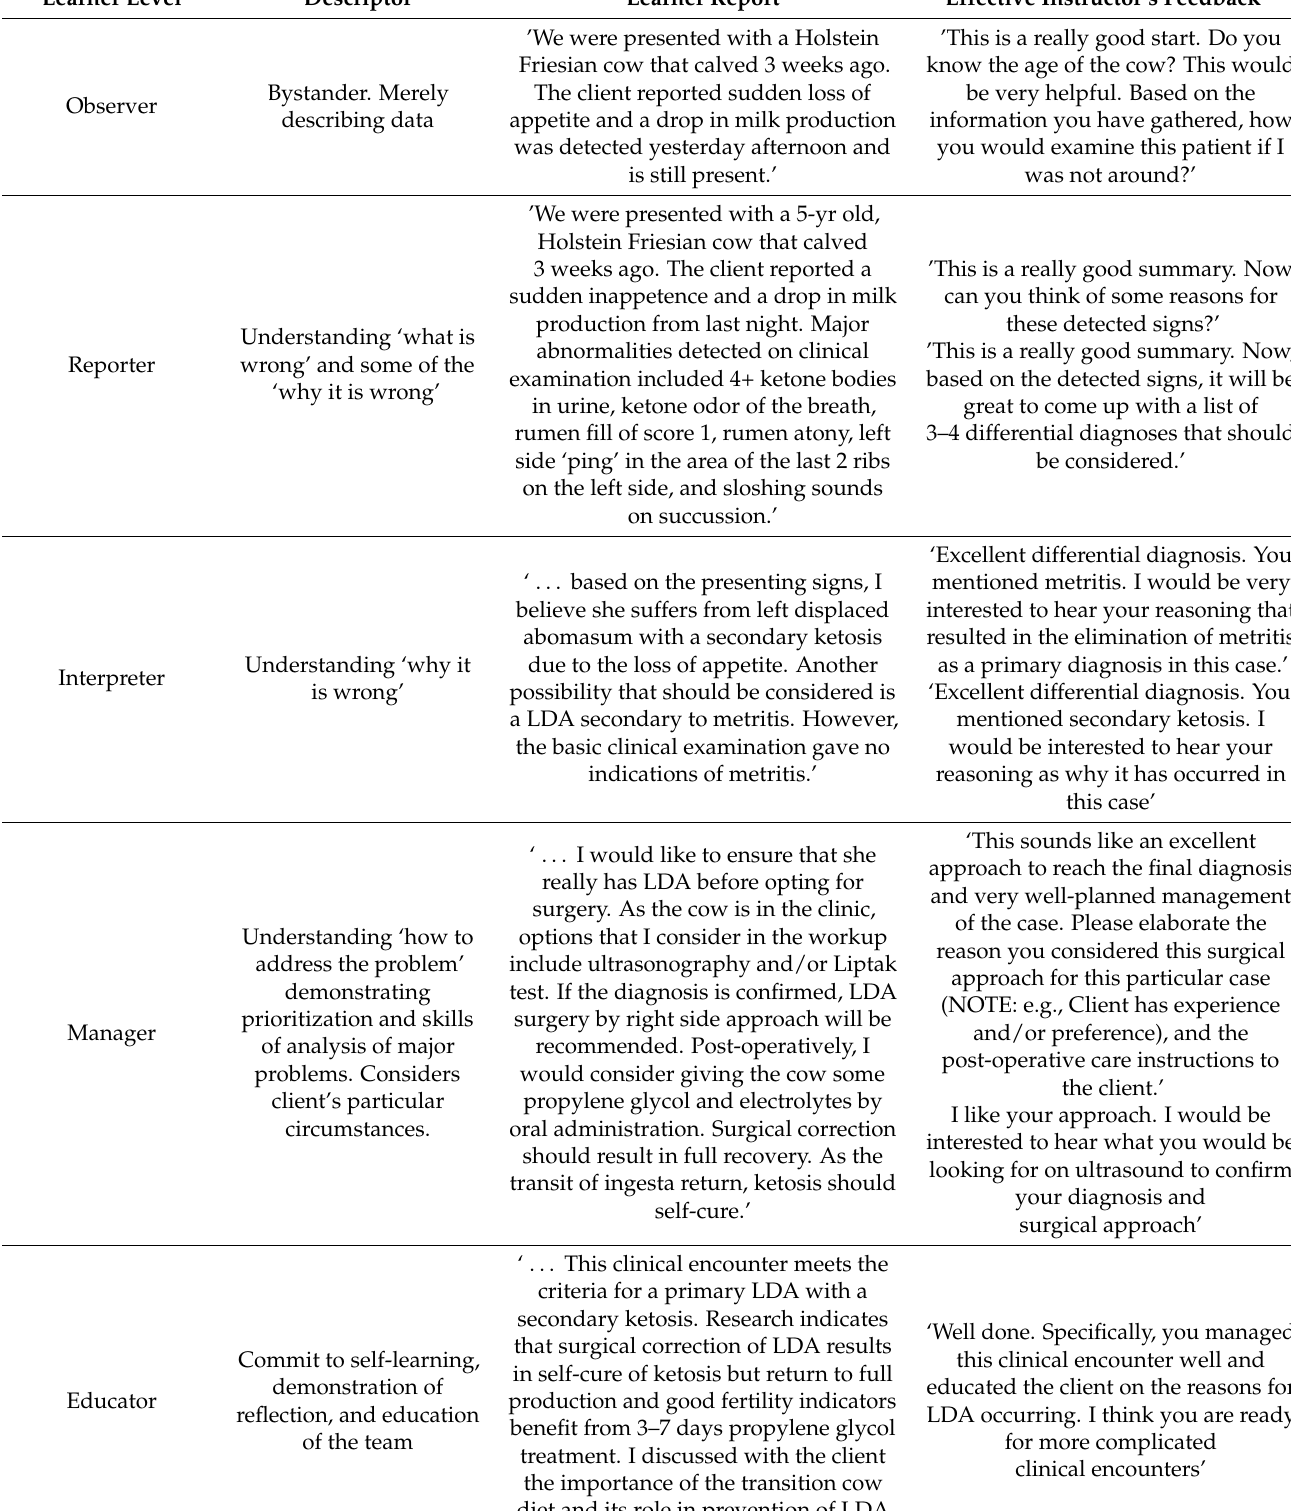
Table 1. Example clinical encounter: Left displaced abomasum in a mature dairy